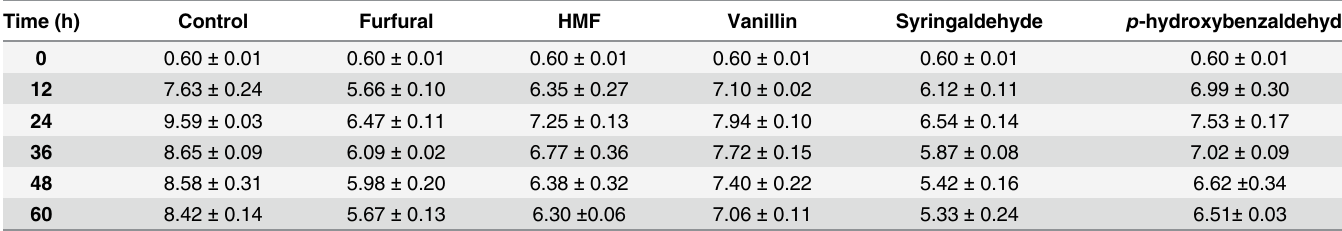
Table 2. Cell biomass (OD 600 ) of B . coagulans GKN316 in the xylose medium with different inhibitors during fermentation. Time